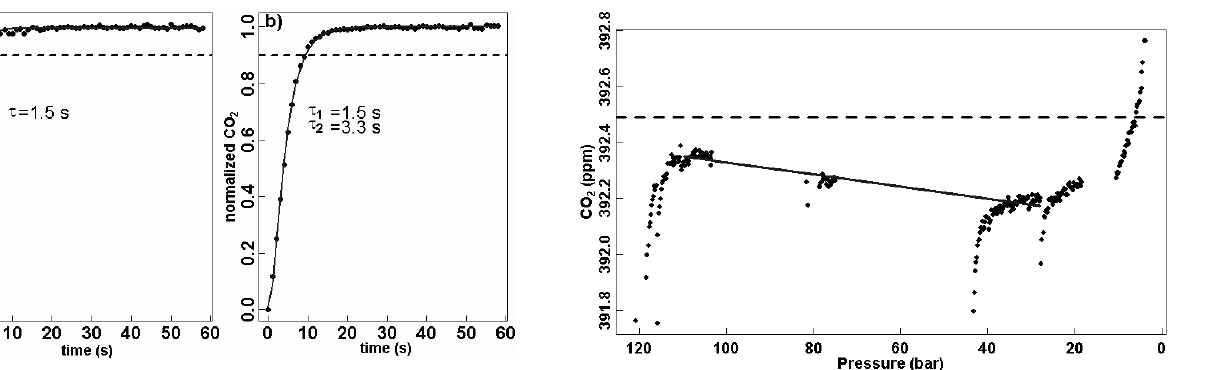
Fig. 3. Long-term stability of CO 2 mixing ratios of one 0.7l cylin- der associated with a pressure regulator from Scott Specialty Gases. The dashed line indicates the mixing ratio of the gas in the filling tank; the solid line shows a long-term